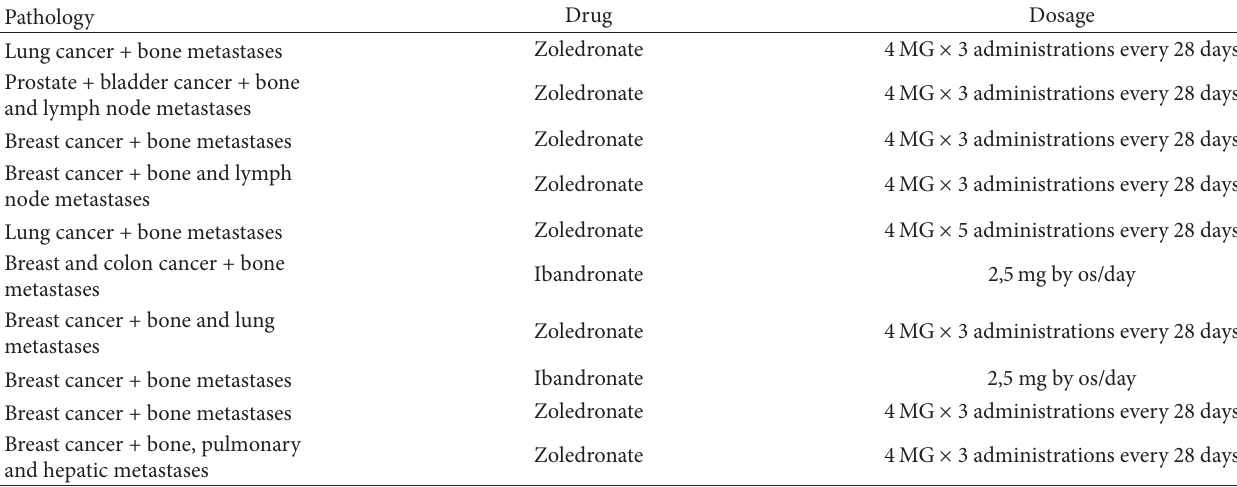
Table 3: Type of drug, administrations, and doses linked to systemic